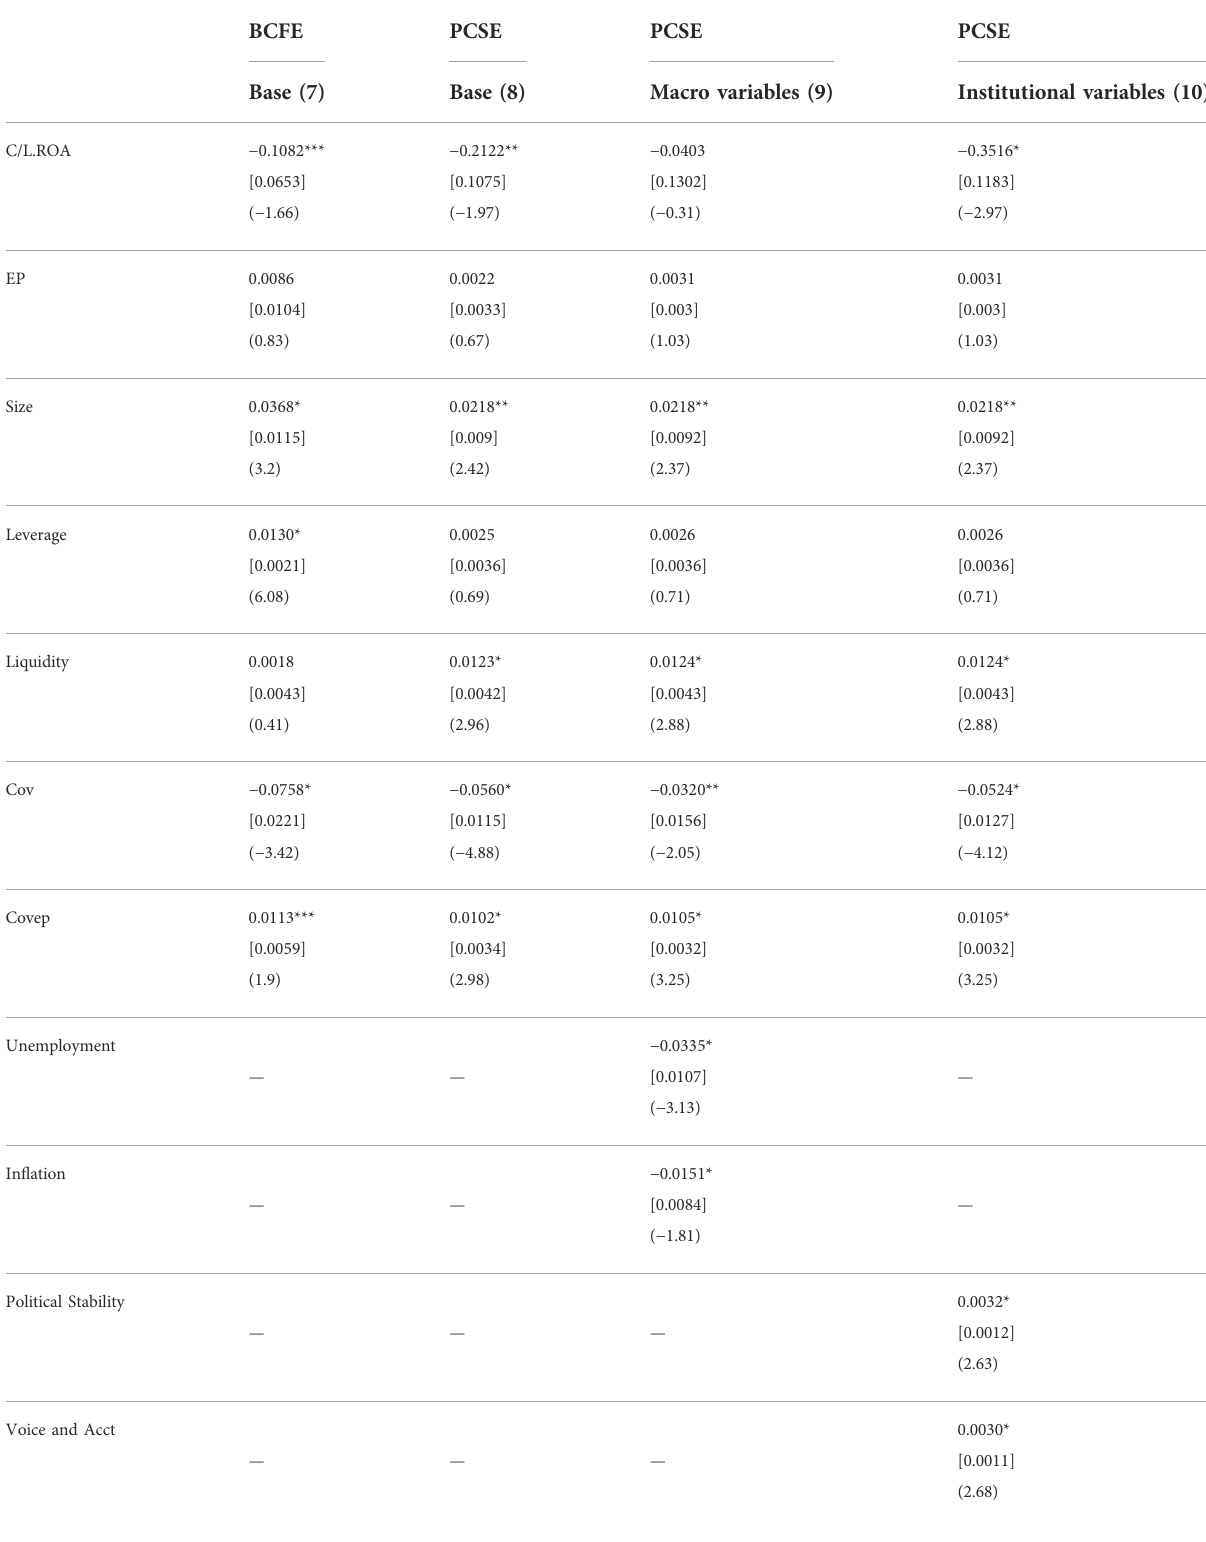
TABLE 4 Robustness of determinants of fi nancial performance